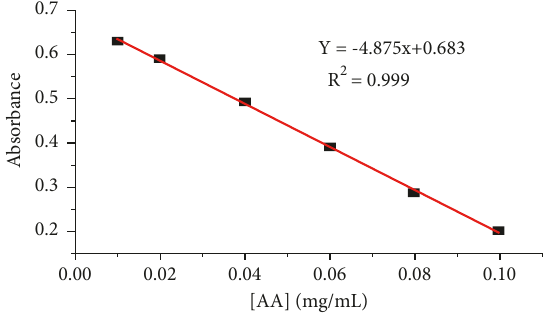
Figure 4: Plot of absorbance of DPPH as a function of various concentrations of ascorbic